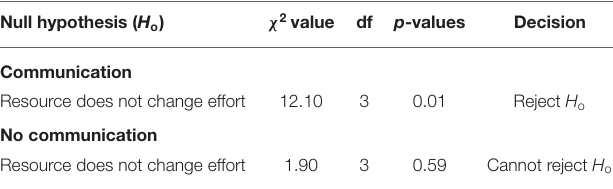
TABLE 3 | Results of the causality test using the Toda-Yamamoto